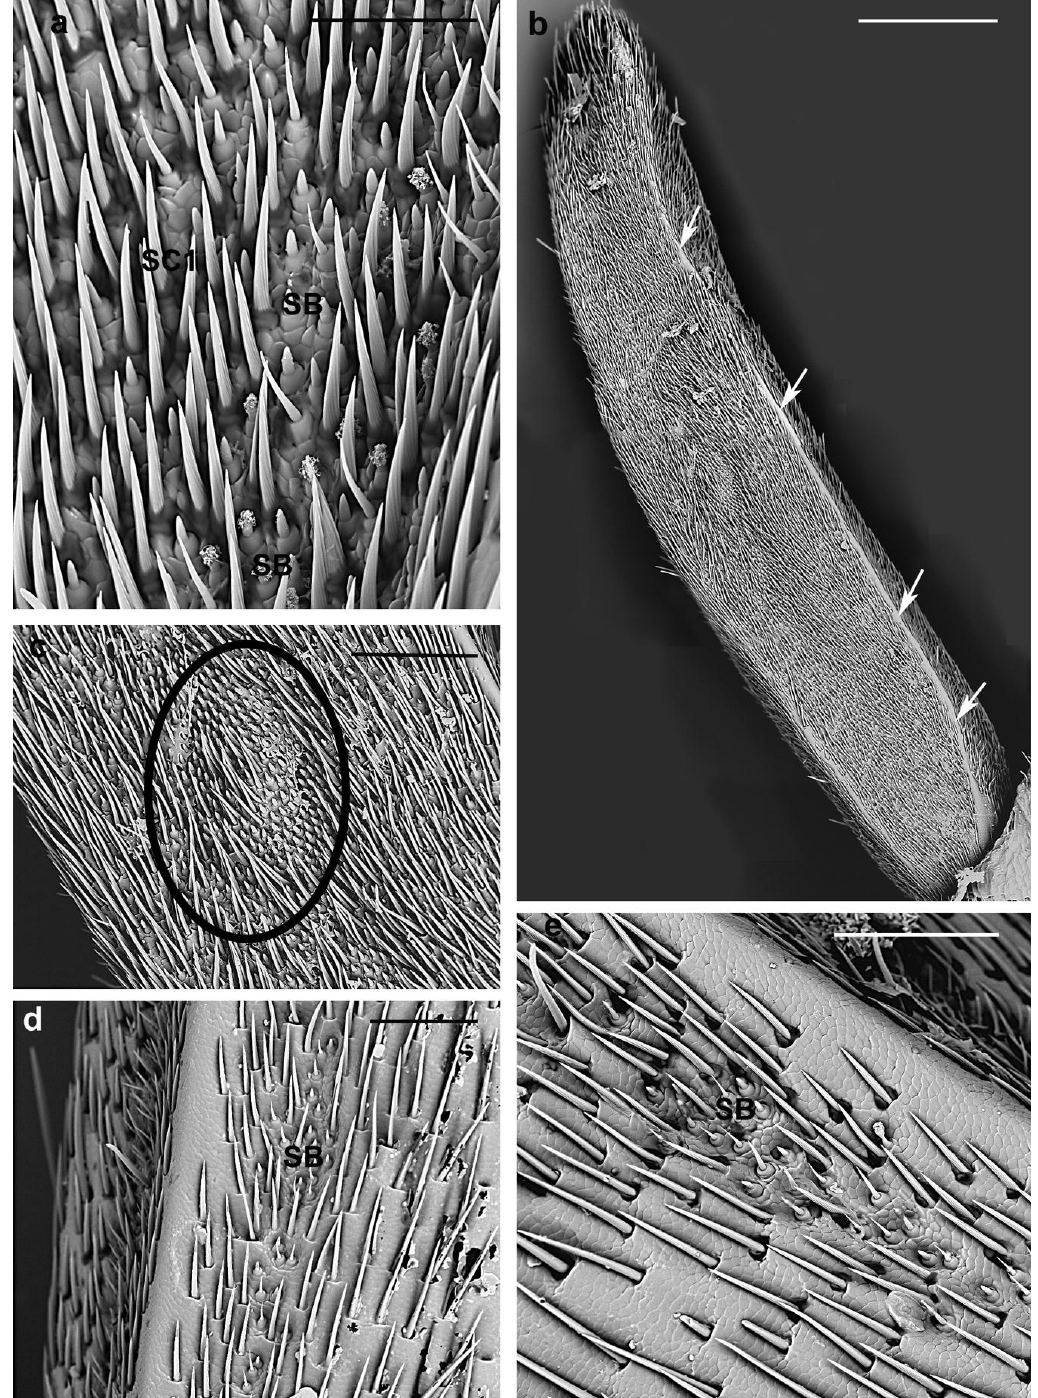
Figure 11. A. bungii female, SEM. Sensilla basiconica. ( a ) SB1 and SB2 densely covered by closely packed SC1. ( b ) Ventro-dorsal view of the ninth flagellomere showing the two bands densely covered by SB, SC and separated by a glabrous strip (arrows). ( c ) Detail of the previous one showing SB organized in very gathered clusters (circle). ( d , e ) Variable concentration of SB along the longitudinal bands. Abbreviations: SB, sensillum basiconicum; SC1, sensillum chaeticum type 1. Scale bars: 50 µm ( a ); 300 µm ( b ); and 100 µm ( c , e ).